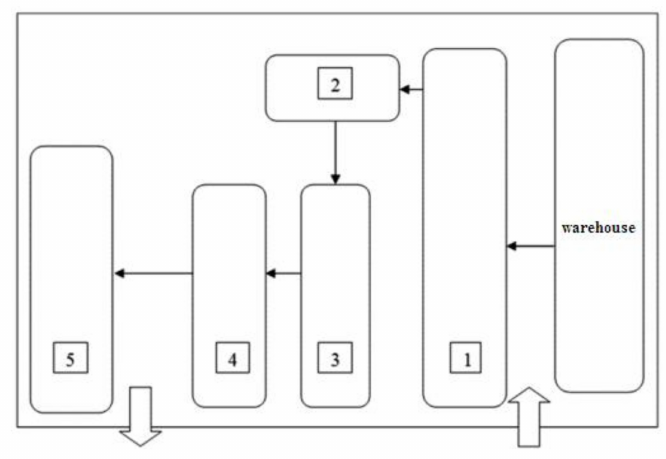
Figure 7. New layout of satellite dish kit production line (after improvement).